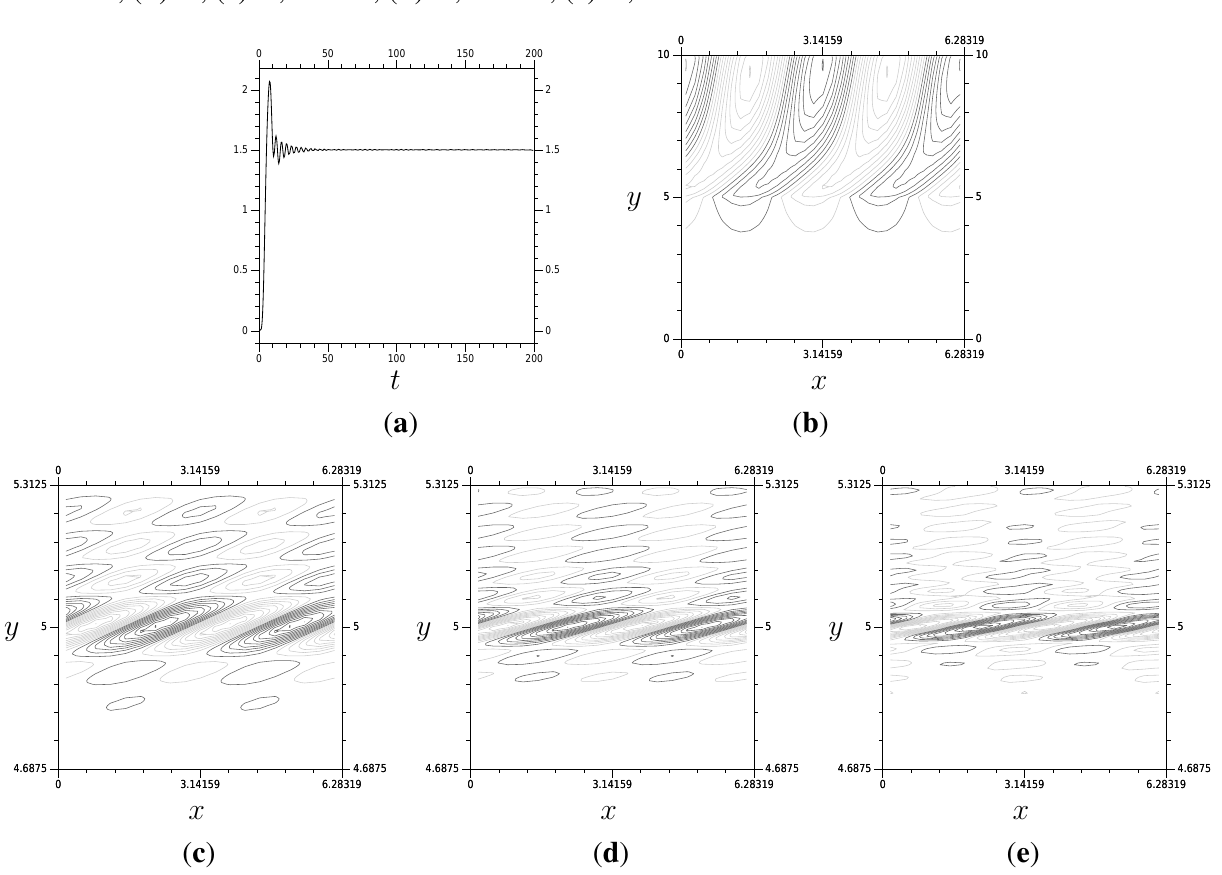
Figure 11. (Top) The flux ( a ), steady state for P ( b ). (Bottom) the progression of Z at t = 50 , 75 , 100 in the x - y plane, from left to right. These use δ = 0 . 2 , β = 1 and ν = ϵ = 0 . Notice that Z increases in amplitude and decreases in wavelength as time increases. ( a )